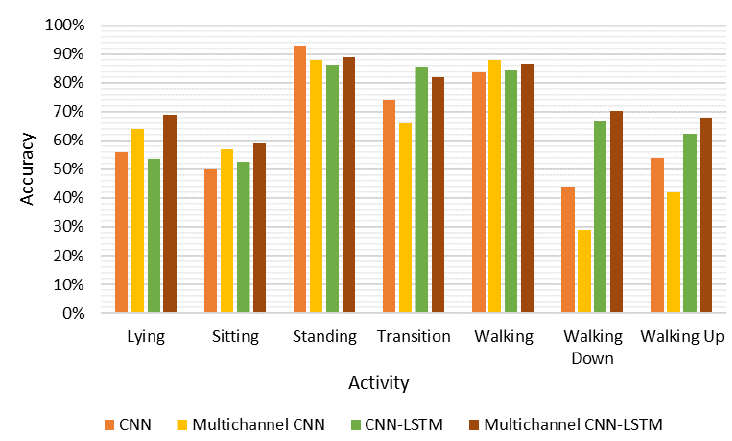
Figure 2. Comparison of the performance of the deep learning modes for each activity class.